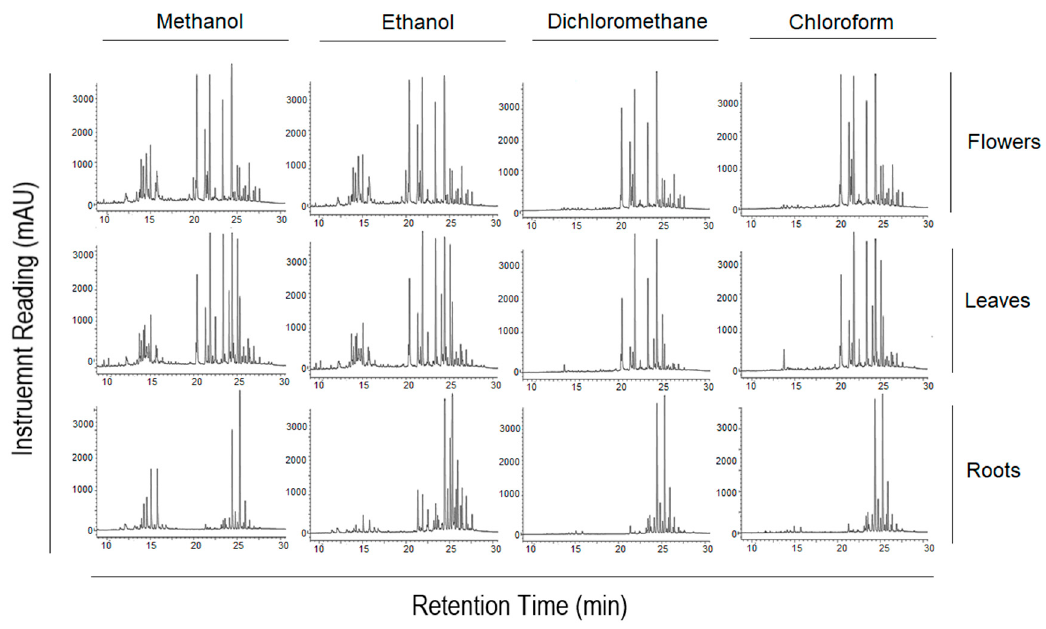
Figure 1. Fingerprinting chromatograms of A. fragrantissima flower-, leaf-, and root-derived solvent extracts using HPLC-UV. The chromatograms are based on a gradient method of methanol and water, and UV set at 275 nm with 5 µ L injection volume. The separation of the dimethyl sulfoxide (DMSO)-dissolved compounds was performed using a Kinetex ® C-18 column (250 × 4.6 mm, 5 µ m) and revealed diverse polar and non-polar compositions for the different solvent extracts of the herbal medicine.